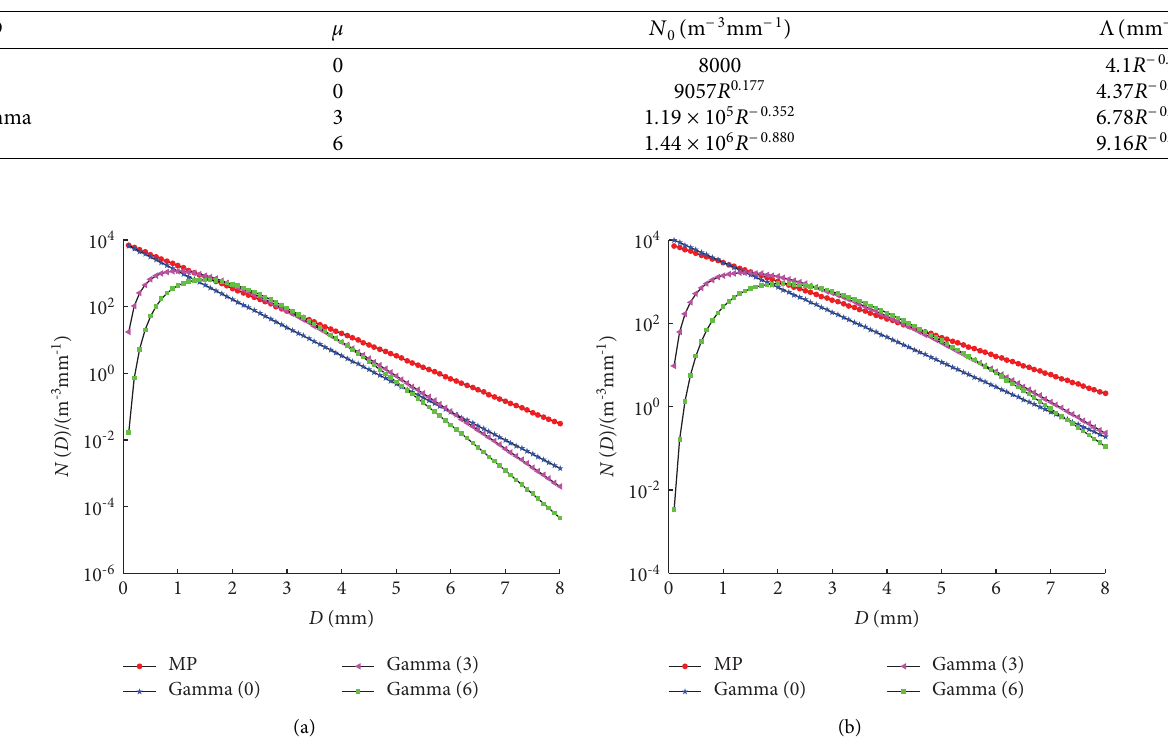
Figure 1: Distribution of raindrops with diferent rainfall intensities. (a) R � 100 mm/h. (b) R �